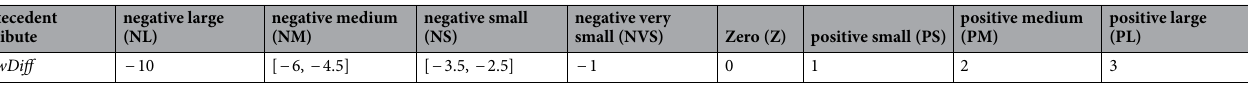
Table 2. The initial references of the FlowDiff.